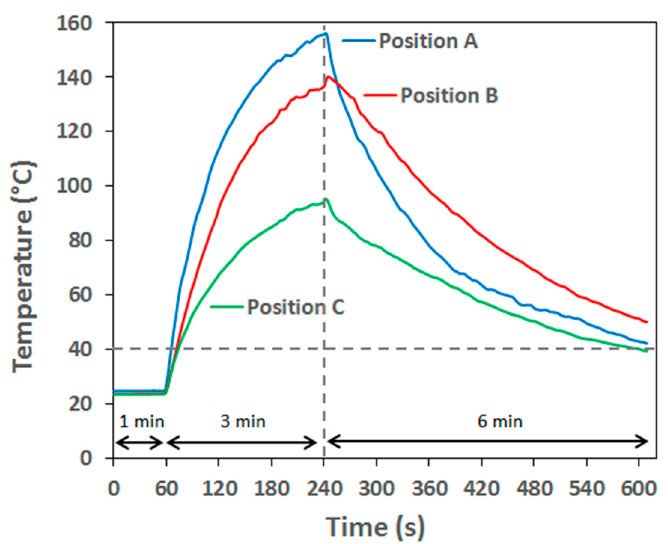
Figure 4. Temperature curves during calibration recorded at clamping end (A), in the middle length of the span (B) and close to the free end (C).